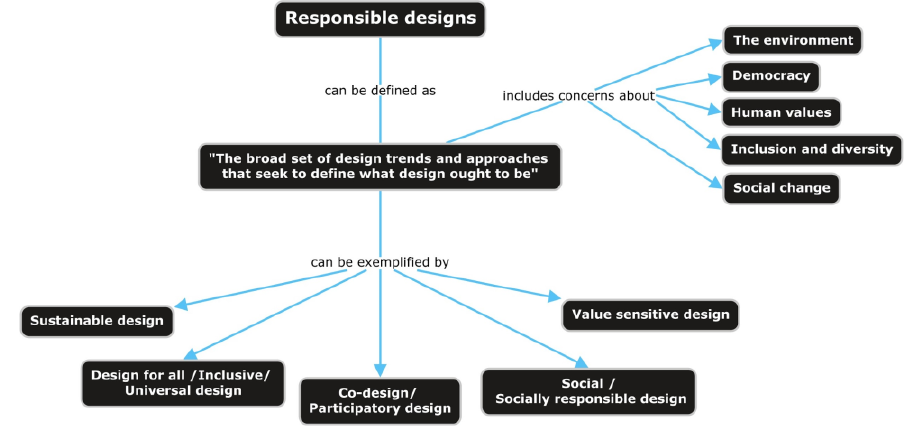
Figure 1. Responsible designs. Original work.